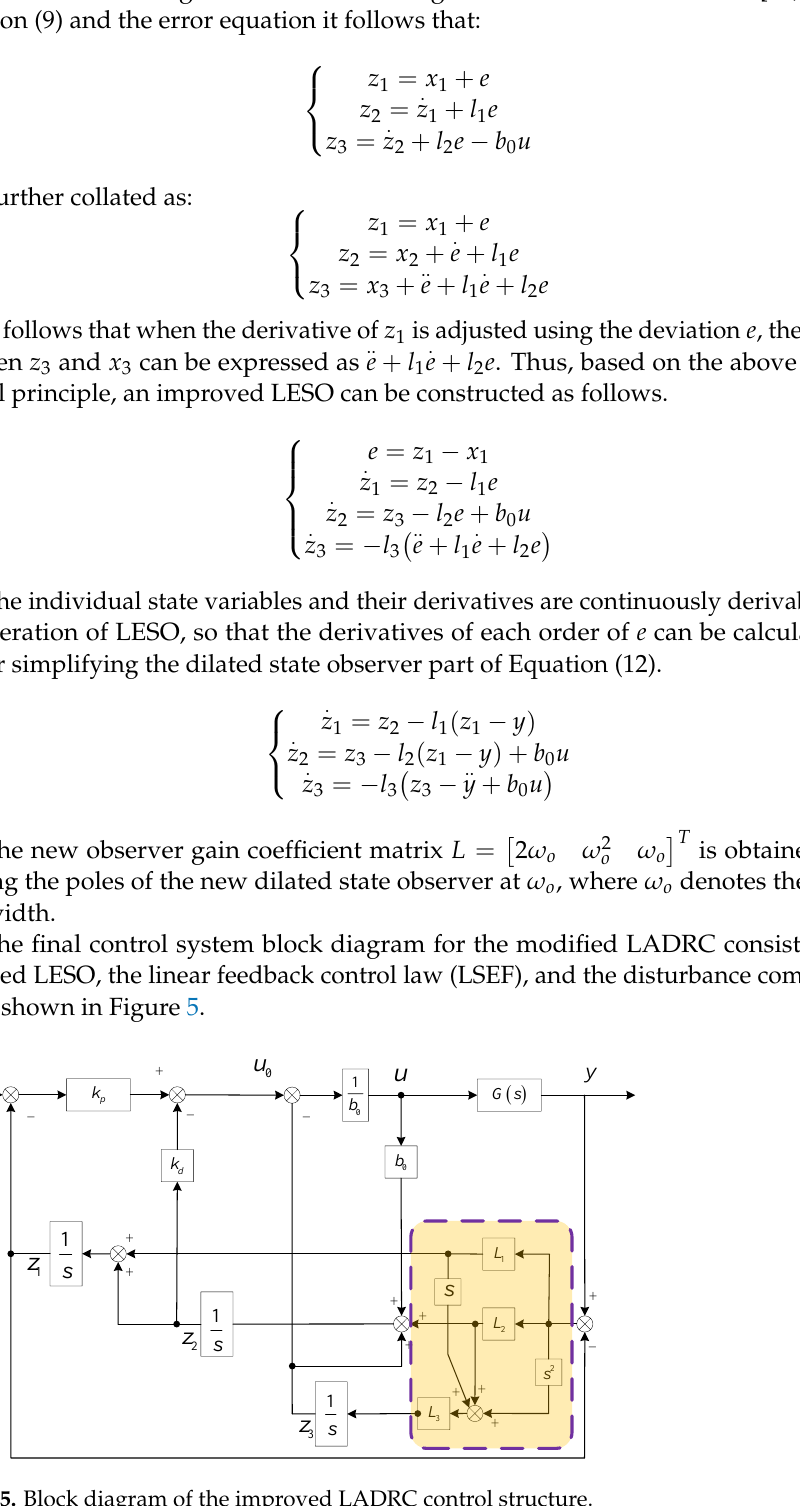
Figure 5. Block diagram of the improved LADRC control structure.